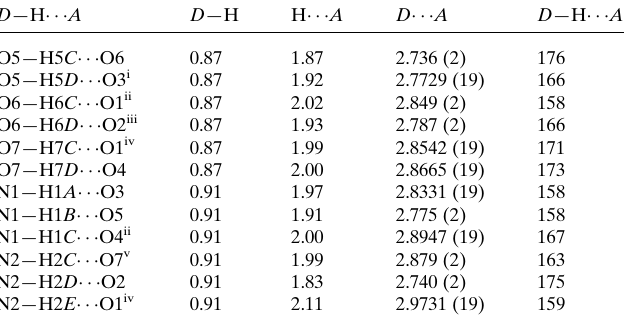
Table 1 Hydrogen-bond geometry (A˚ , (cid:5) ).